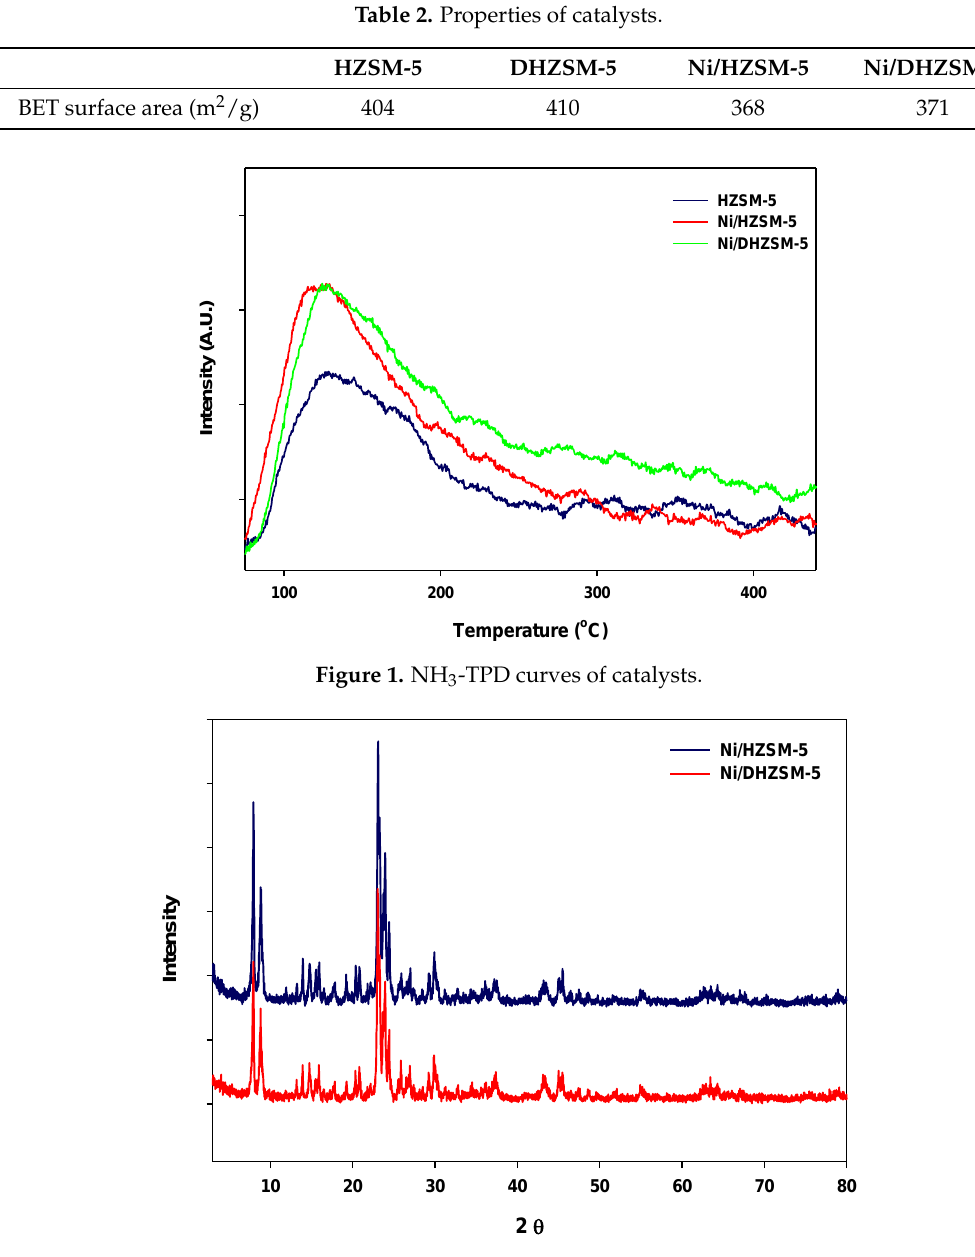
Figure 2. XRD patterns of catalysts.